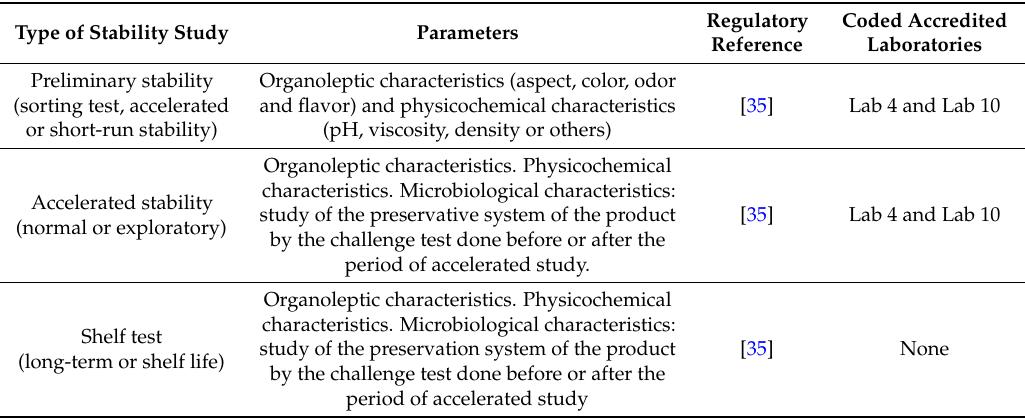
Table 6. Accredited laboratories for the evaluation of the stability of cosmetic products: organoleptic and physicochemical parameters.